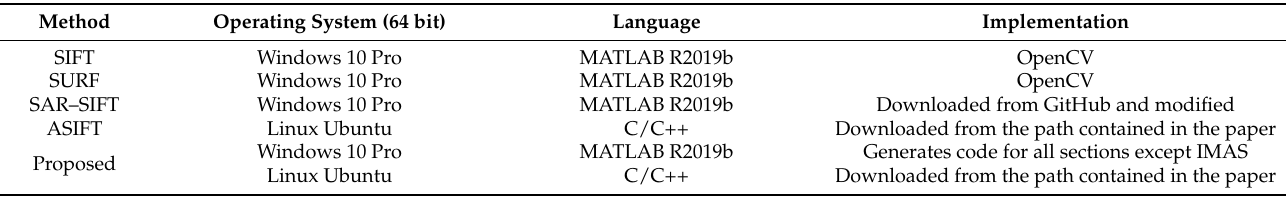
Table 4. The software environments of matching